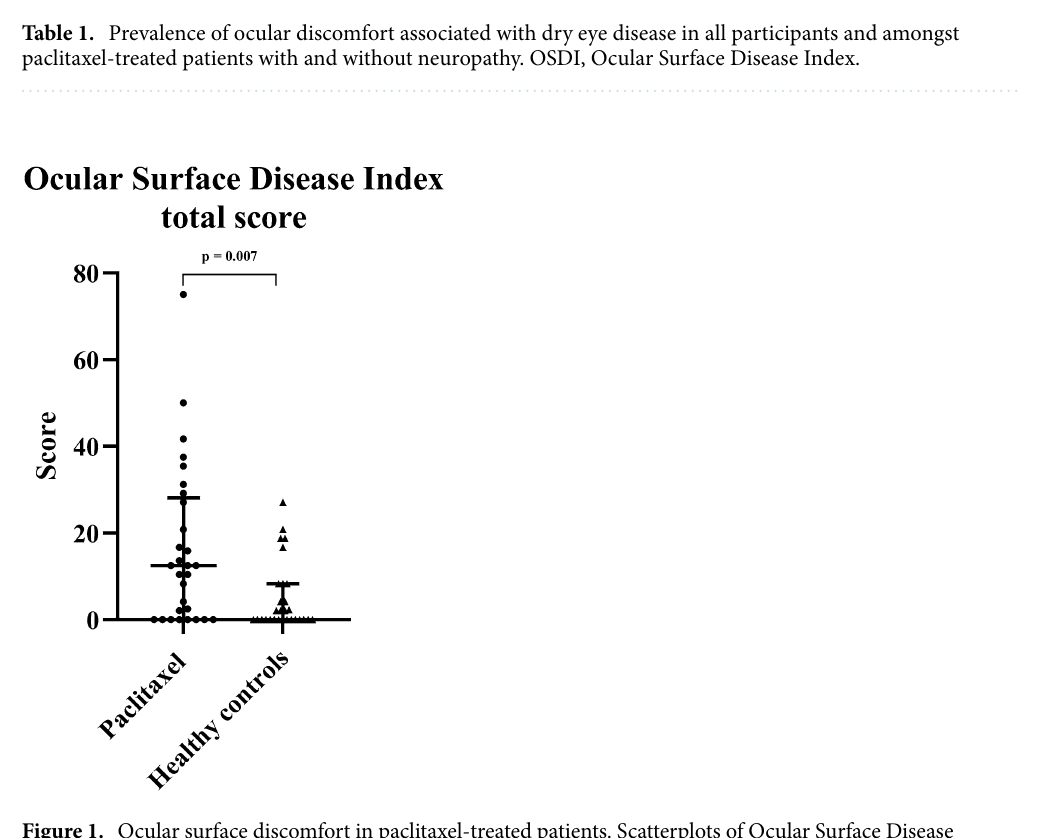
Figure 1. Ocular surface discomfort in paclitaxel-treated patients. Scatterplots of Ocular Surface Disease Index (OSDI) scores for the paclitaxel group and healthy controls. The median and interquartile ranges are also